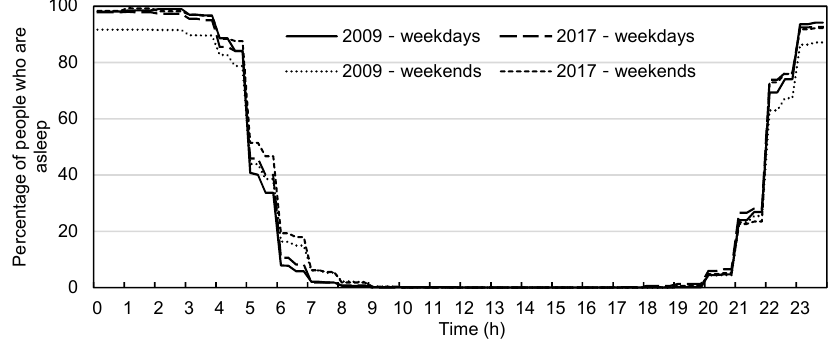
Figure 9. Comparison of sleeping time between the 2009 and 2017 surveys conducted at Noi Bai airport.